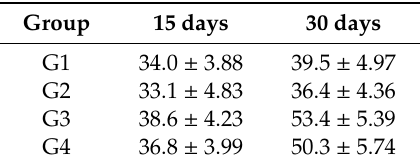
Table 6. Bonferroni’s multiple comparison test to compare the BIC% values between the groups. 15 days 30 days Group Mean of p- value 95% CI Comparison Diff. G1 vs G2 0.9333 G1 vs G4 − 2.744 G2 vs G3 − 5.522 0.0133 G2 vs G4